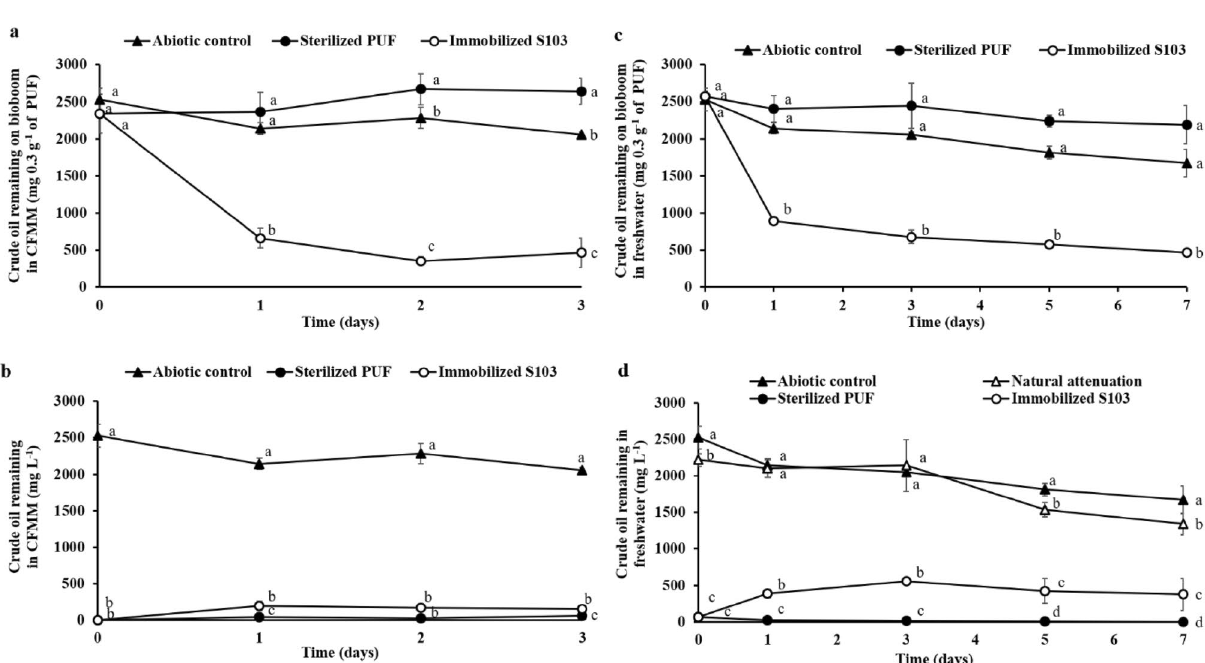
Figure 4. Removal efficiency of crude oil by R. ruber S103 on biobooms ( a and c ) and in liquid culture ( b and d ) and at room temperature with shaking at 200 rpm for 3 and 7 days. The removal was carried out in CFMM medium ( a and b ) and freshwater ( c and d ), which contained 2500 mg L −1 AL crude oil. The lowercase letters above the vertical bars represent significant differences in incubation time ( P <